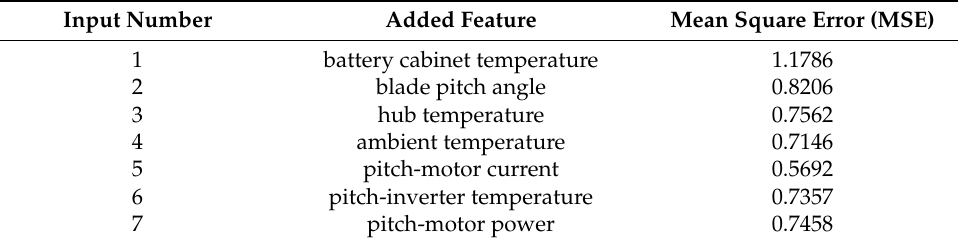
Table 2. The results of the sequential forward selection.